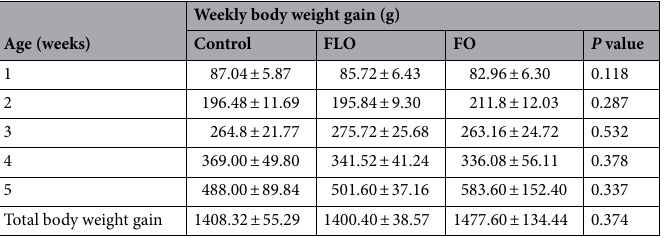
Table 4. The effects of different supplemental oils on the weekly body weight gain at different ages of broilers. Values are means ± SD. FLO flaxseed oil, FO fish oil.